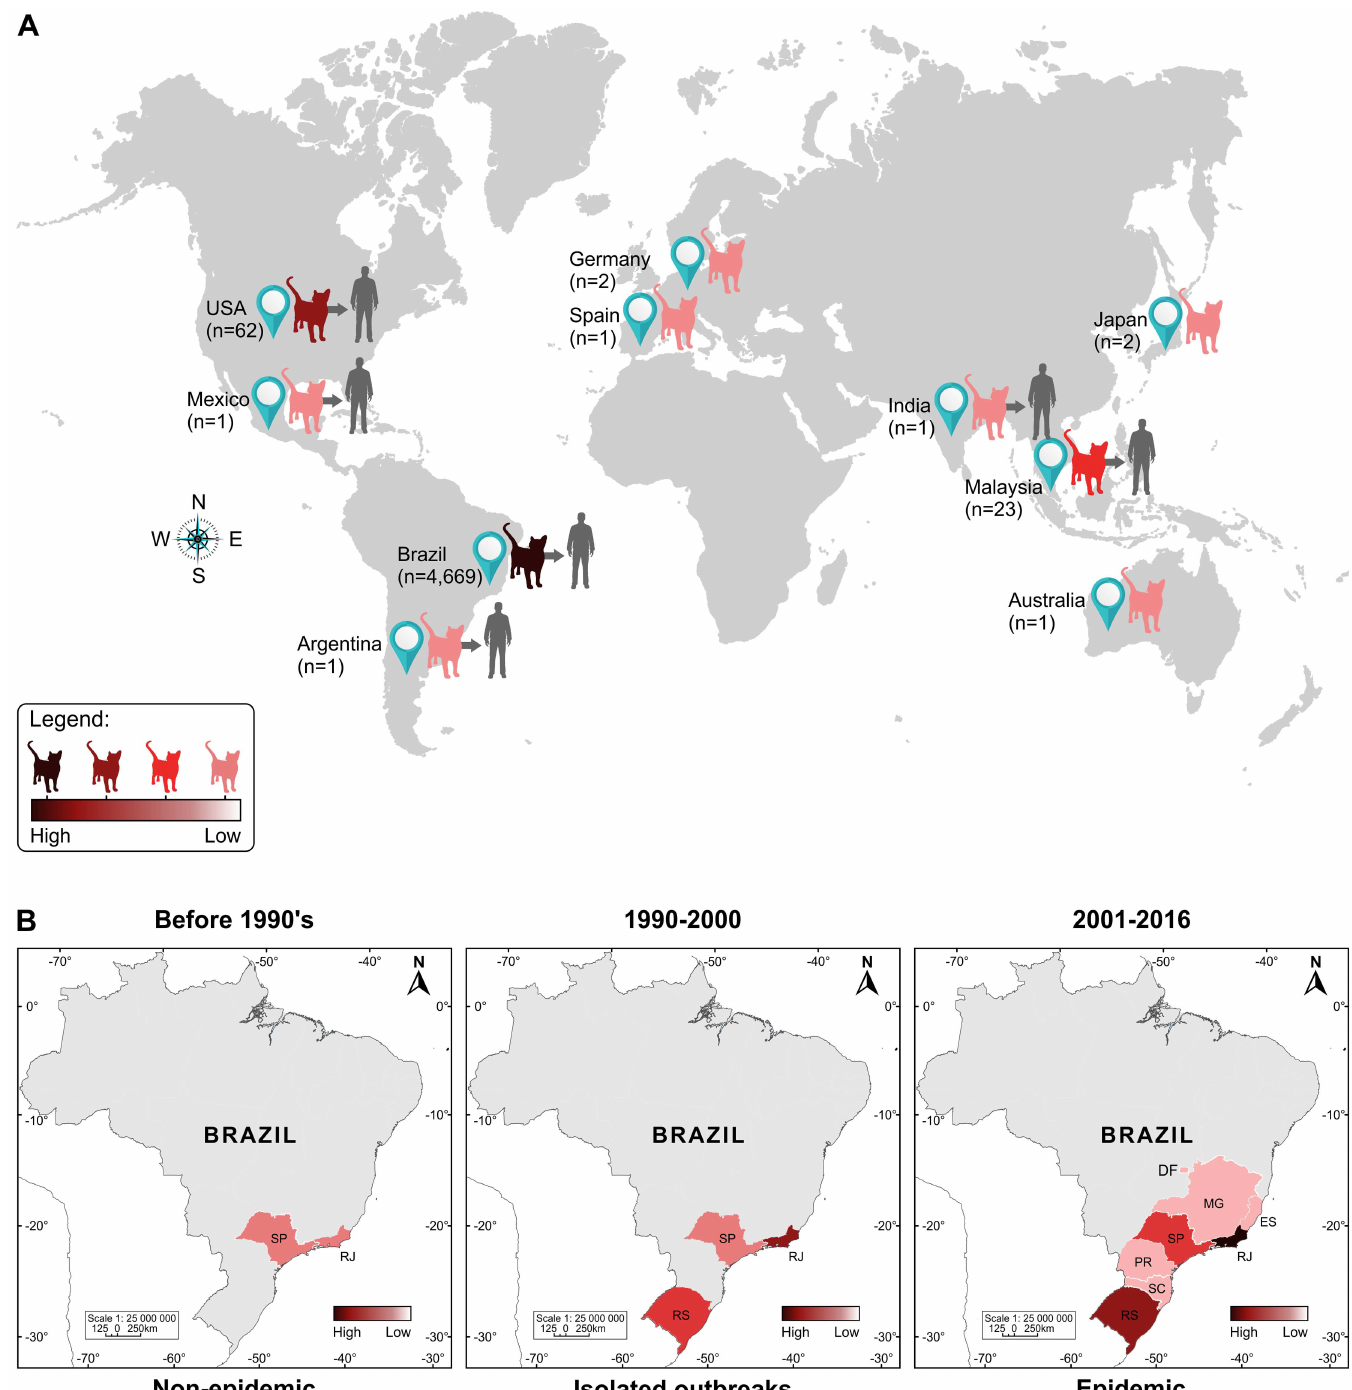
Fig 1. Feline sporotrichosis cases around the world, 1952–2016. (A) Since the mid-20th century, feline sporotrichosis has typically occurredin isolated cases and small outbreaks, and only a few reports of zoonotictransmissionhave been describedin the literature. The Southeast Brazil regionhas the largest absolutenumber of cases with an overwhelming prevalence of S . brasiliensis duringepizooticoutbreaks. Outside Brazil, most feline cases are due to the classical agent S . schenckii .(B) Spatiotemporal evolutionof feline sporotrichosis cases in Brazil. Over the last two decades(1998–2016), Brazil has experienced a long-lastingoutbreakof cat-transmitted sporotrichosis in Rio de Janeiro,with 4,669 cases reported. Cat-bornesporotrichosis due to S . brasiliensis often appearsin the form of outbreaks or epidemics within a short periodof time. Remarkably, before the 1990s, Rio de Janeiroreporteda low number of cases, nearly always unrelated to feline